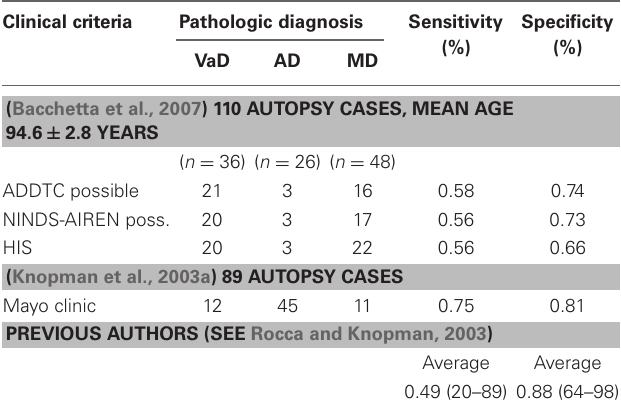
Table 1 | Diagnostic accuracy of possible VaD.